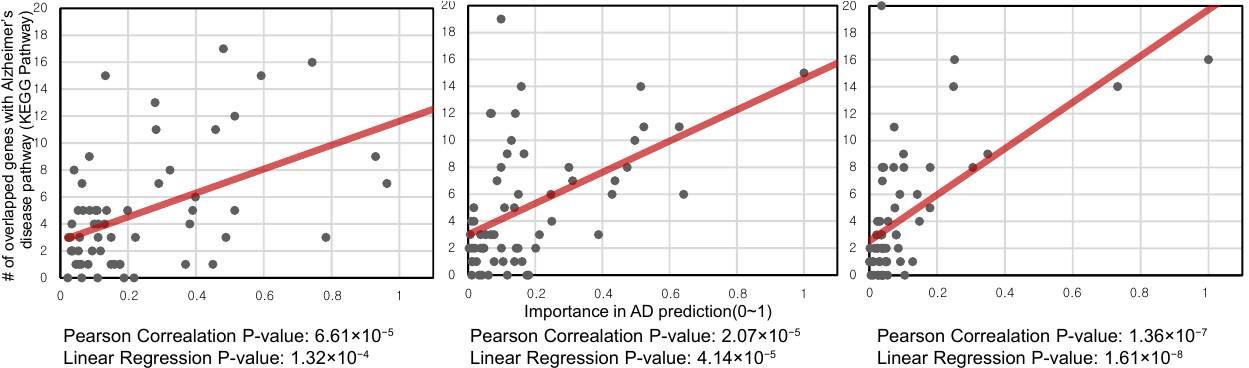
Figure 6. Relationship between the genes overlapping with Alzheimer’s disease (AD) KEGG pathway and importance in AD prediction. For each module, linear regression was performed, and the Pearson correlation was calculated for the relationship between the number of genes overlapping with the AD KEGG pathway and LIME importance for AD prediction. Three examples with different hyperparameters are shown: the best performing two-layer model ( left ), the best performing three-layer model ( middle ), and the best performing four-layer model ( right ) in the AD/NL classification task on the Addneuromed